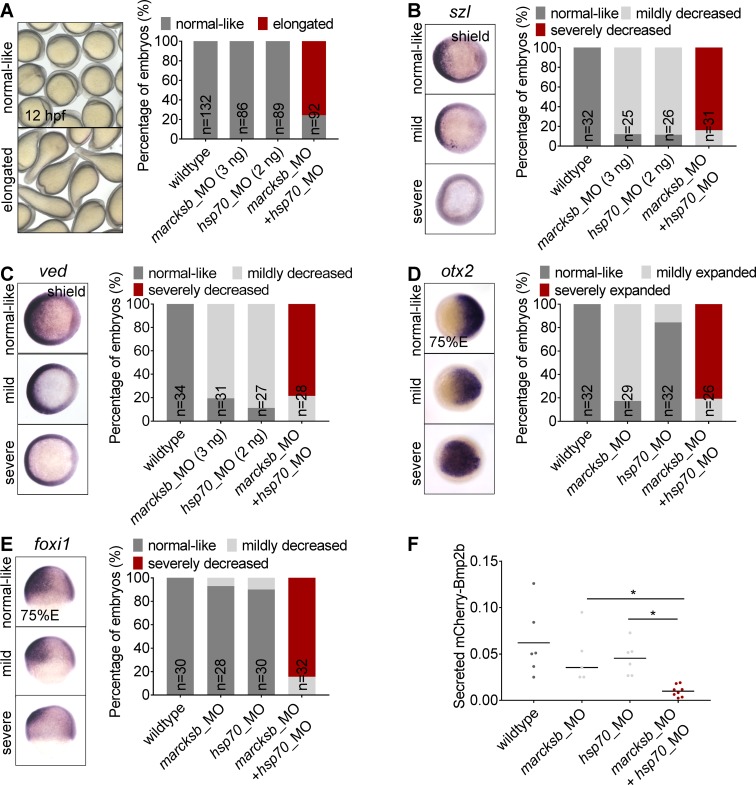
Marcksb interacts with Hsp70.3 to regulate the dorsoventral patterning and the extracellular level of Bmp2b.(A) Morphological phenotypes of embryos at 12 hpf, injected with sub-dosages of morpholinos against marcksb or hsp70 or the combination of both (marcksb_MO: 3 ng/embryo; hsp70_MO: 2 ng/embryo). (B-E) WISH analysis of szl (B), ved (C), otx2 (D), foxi1 (E). The percentage of embryos with different phenotypes for each group were indicated in the graph. Dosages of morpholino per embryo are indicated in the figure panel. For szl, ved and otx2, embryos are animal-pole view with dorsal to the right; for foxi1, embryos are lateral view with dorsal to the right. “n” represents the number of embryos we observed. (F) Quantitative measurement of secreted Bmp2b. The data were presented as scatter plots with median; “*”: P < 0.01, from Student’s t-test.